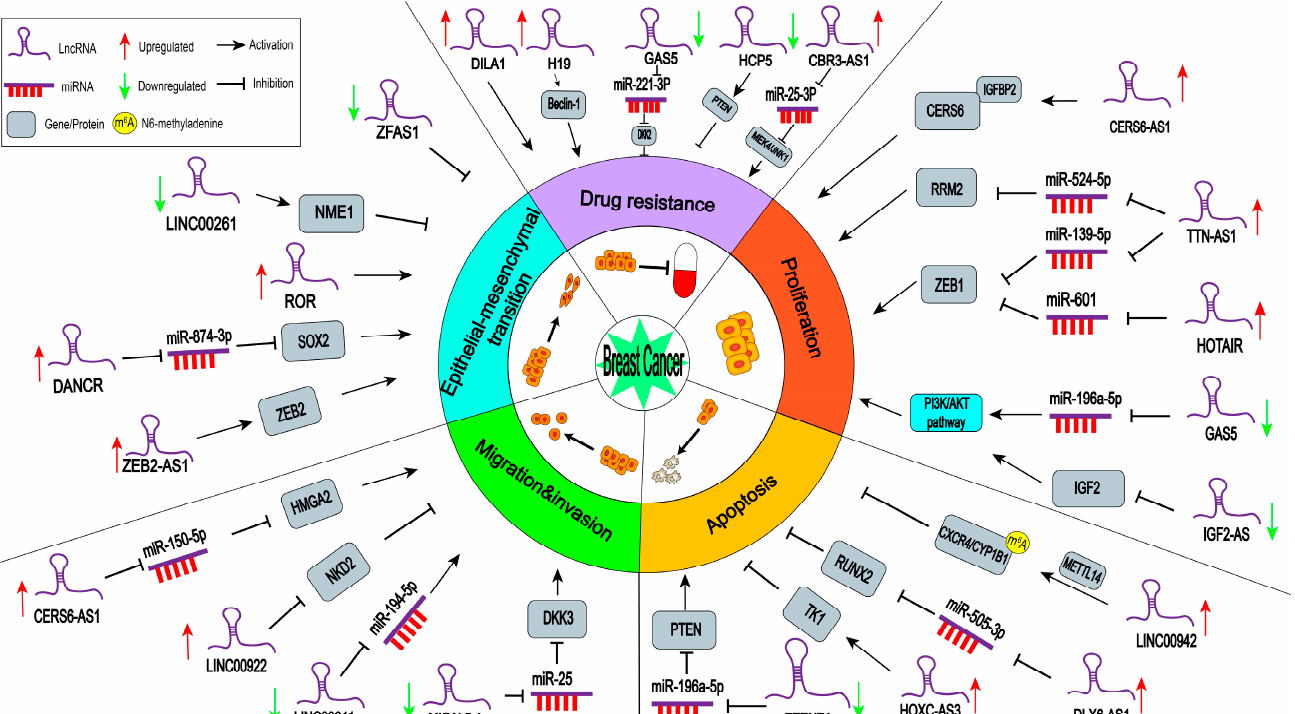
Abbreviations: HR: hazard ratio; AUC: area under the curve.